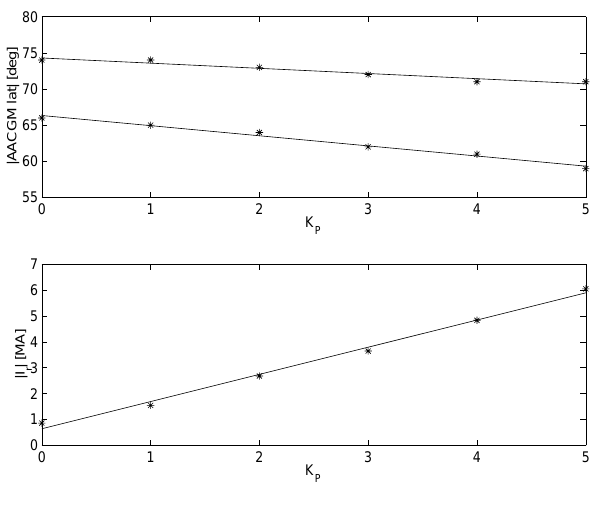
Fig. 7. The equatorward and poleward boundaries of the oval and the total field-aligned current as a function of K p